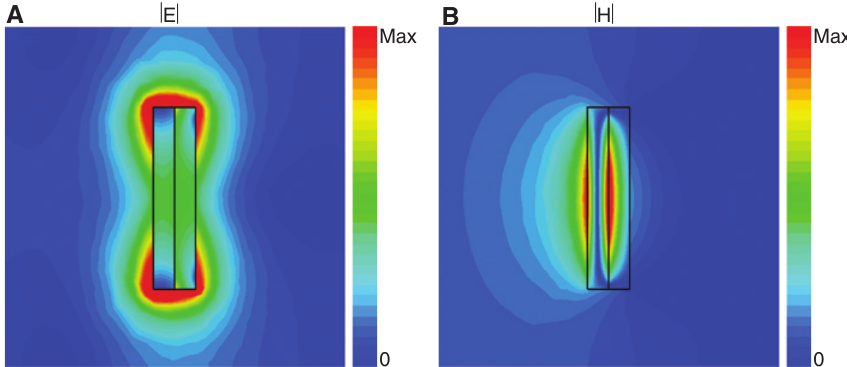
Figure 3: Distributions of the electric and magnetic fields on the y - z plane at the frequency of 248.24 THz for normally incident y polarized light. (A) and (B) show the distributions of the electric and magnetic fields, respectively. The black solid line outlines the